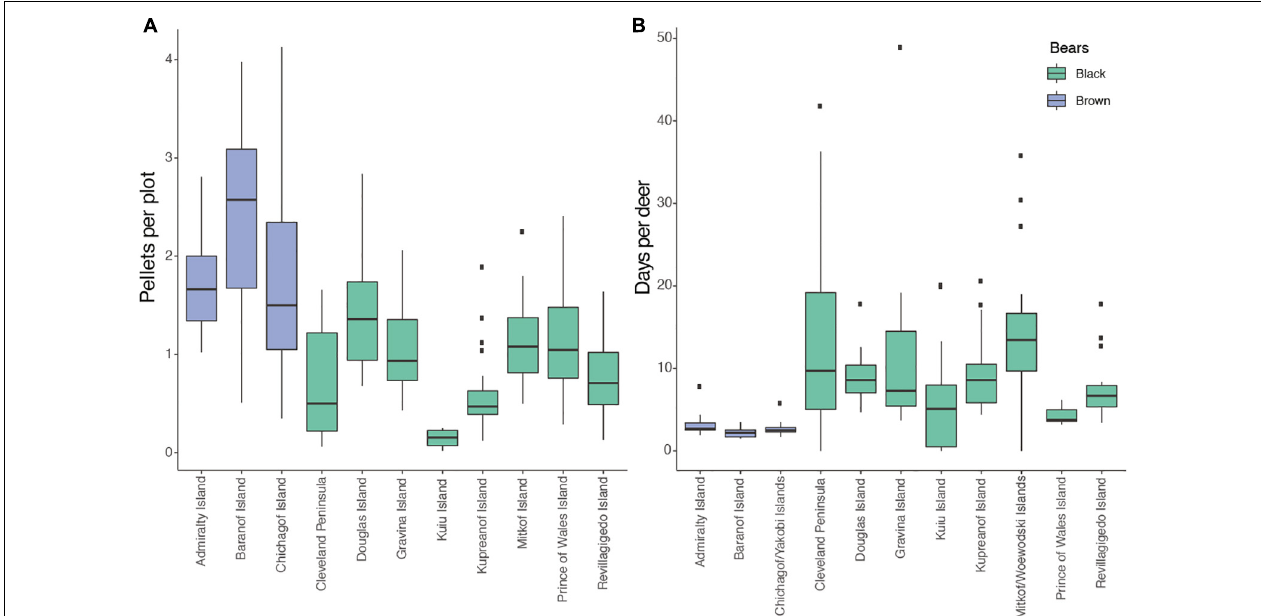
FIGURE 4 | Indices of deer abundance from Alaska Department of Fish and Game in regions with only brown bears and those that are black bear dominated. A small brown bear population exists on the Cleveland Peninsula (annual harvest < 1 individual) and Revillagigedo (annual harvest < < 1 individual). Some additional islands have recently been colonized by brown bears. Wolves do not occur on brown bear islands. (A) Deer pellet groups per plot across 52 survey locations spanning 11 distinct geographic regions in Southeast Alaska. Data include time series of at least 4 years spanning 1981–2016. (B) Days of hunting per deer harvested from 1997 to 2019. Lower values indicate that hunters more quickly find deer, suggesting a higher density of deer.